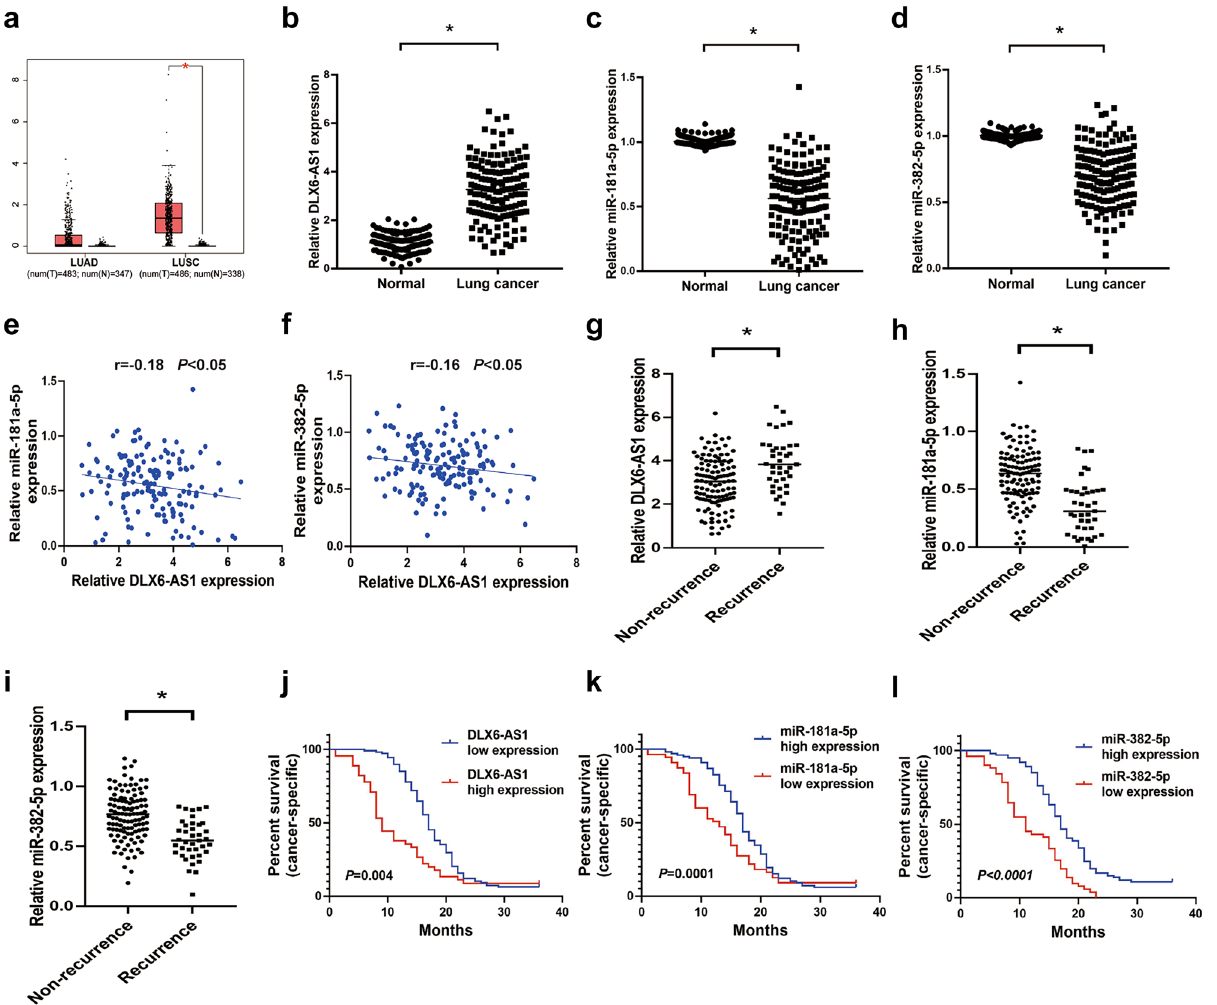
Figure 1. DLX6-AS1 was highly expressed in LUSC tissues and was negatively correlated with miR-181a-5p and miR-382-5p expression. ( a ) The relative expression of DLX6-AS1 in lung adenocarcinoma tissues (LUAD, n = 483) and normal tissues (n = 347), as well as in lung squamous cell carcinoma tissues (LUSC, n = 486) and normal tissues (n = 338) based on GEPIA. ( b ) qRT-PCR analysis for the relative expression of DLX6-AS1 in LUSC tissues (n = 153) and para-cancer tissues (n = 153). ( c ) qRT-PCR analysis of miR-181a-5p expression in LUSC tissues (n = 153) and para-cancer tissues (n = 153). ( d ) qRT-PCR analysis of miR-382-5p expression in LUSC tissues (n = 153) and para-cancer tissues (n = 153). ( e ) Spearman correlation analysis for the expression levels of DLX6-AS1 and miR-181a-5p in LUSC tissues. ( f ) Spearman correlation analysis for the expression levels of DLX6-AS1 and miR-382-5p in LUSC tissues. ( g ) qRT-PCR analysis for the relative expression of DLX6-AS1 in local recurrence LUSC tissues (n = 39) and non-recurrence LUSC tissues (n = 114). ( h ) qRT-PCR analysis of miR-181a-5p expression in local recurrence LUSC tissues and non-recurrence LUSC tissues. ( i ) qRT- PCR analysis of miR-382-5p expression in local recurrence LUSC tissues (n = 39) and non-recurrence LUSC tissues (n = 114). ( j ) The cancer-specific survival of LUSC patients was estimated by Kaplan–Meier survival analysis according to DLX6-AS1 expression levels. ( k ) The cancer-specific survival of LUSC patients was estimated by Kaplan–Meier survival analysis according to miR-181a-5p expression levels. ( l ) The cancer-specific survival of LUSC patients was estimated by Kaplan–Meier survival analysis according to miR-382-5p expression levels. * P <